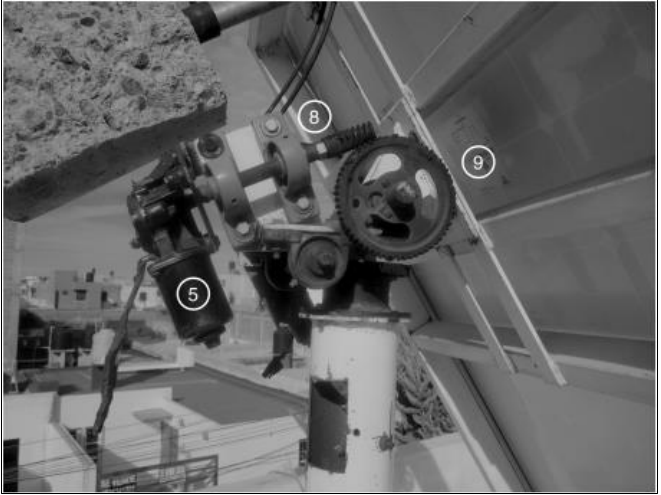
Figure 5: Shows the parts of the azimuthal axis. Source: Authors, (2022).